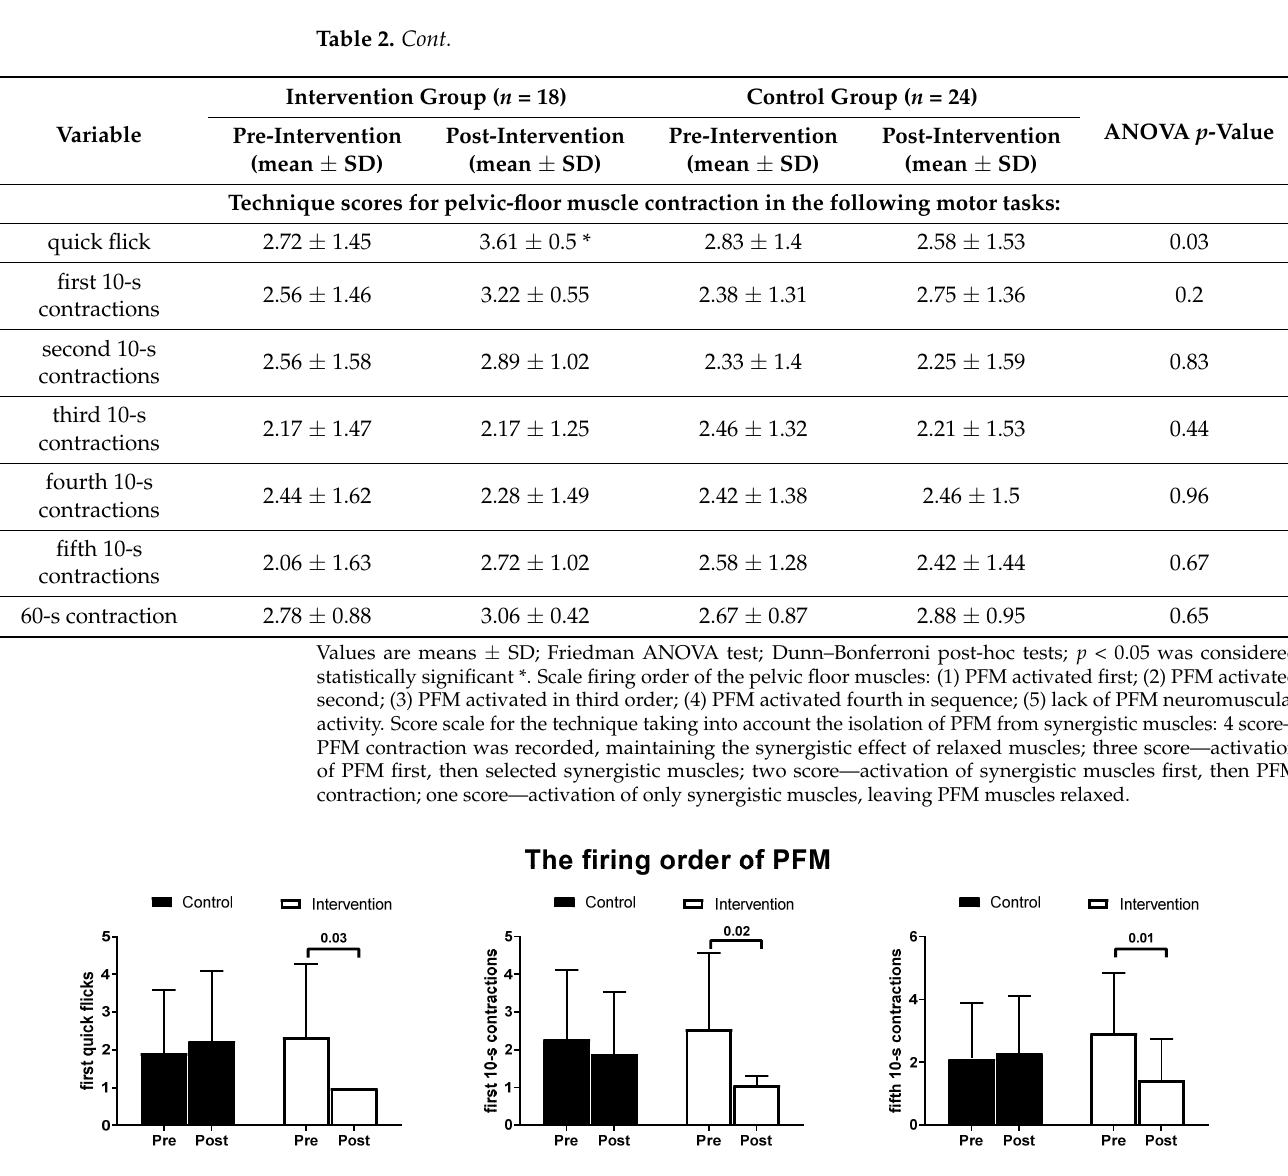
Figure 2. Changes in the firing order of the pelvic floor muscles in: ( a ) quick flick; ( b ) first 10-s contractions; ( c ) fifth 10-s